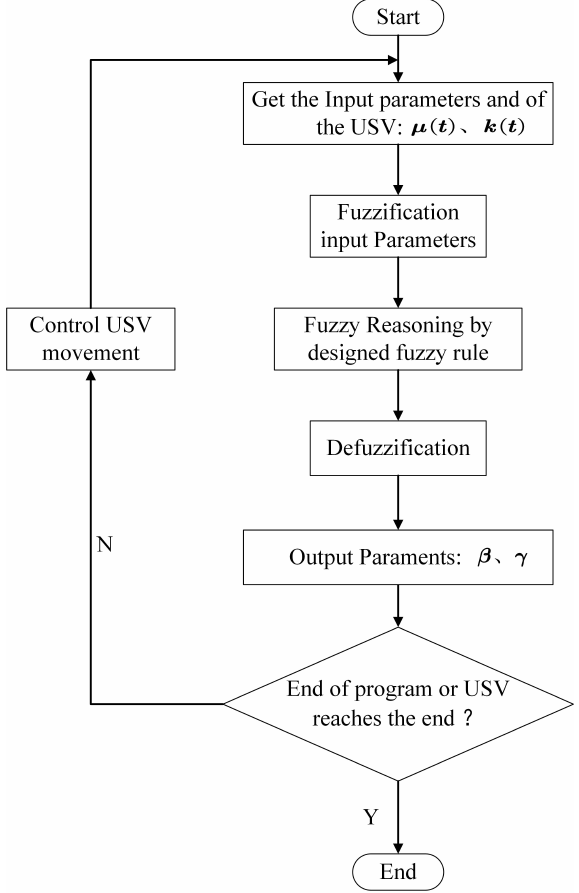
Figure 8. Fuzzy control flow